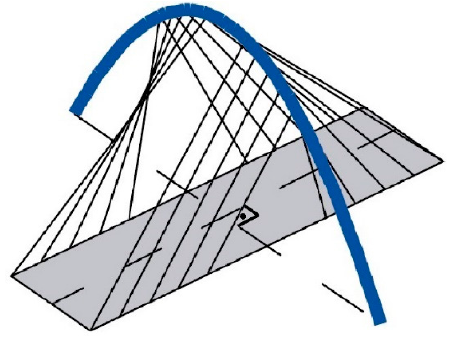
Figure 4. Schematic illustration of a perpendicular arch bridge (PAB).